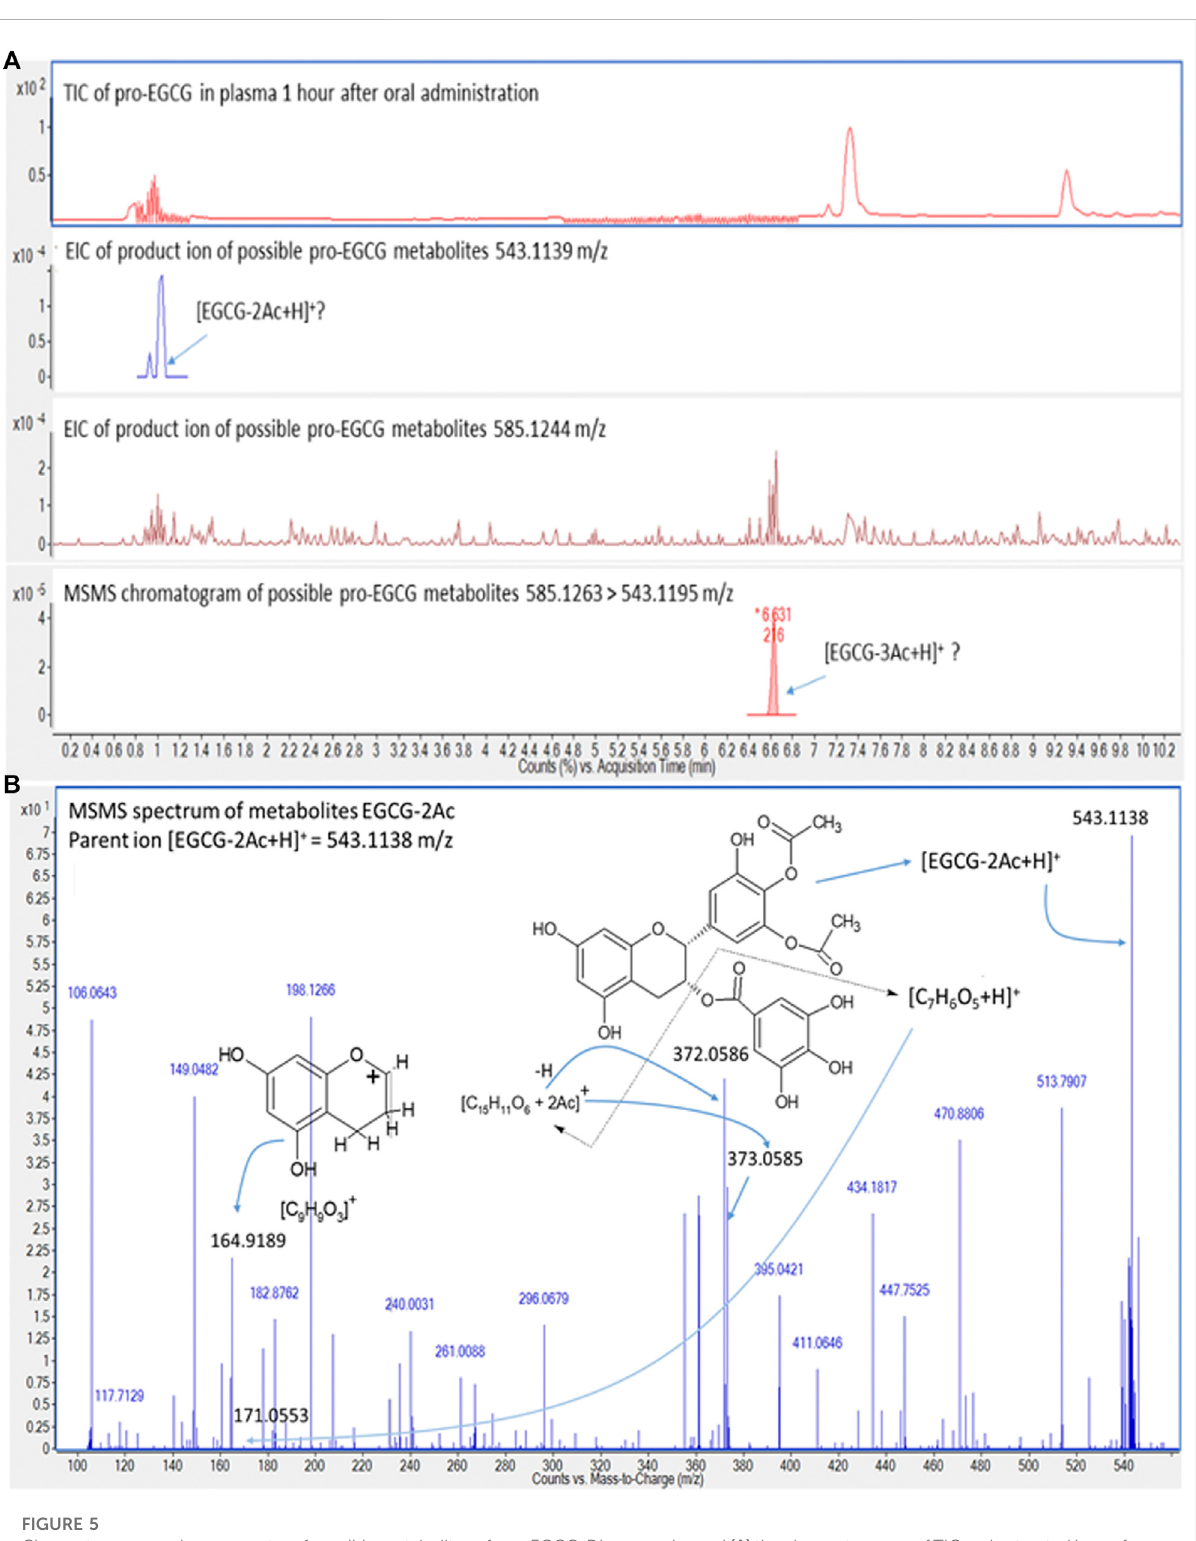
FIGURE 5 Chromatogramsandmassspectraofpossiblemetabolitesofpro-EGCG.Diagramsshowed (A) thechromatogramsofTICandextractedionsof the proposed metabolites, EGCG diacetates [EGCG-2Ac + H]+ (second chromatogram) and EGCG triacetates [EGCG-3Ac + H]+ (third chromatogram) in plasma extract 1 h after oral administration of 50 mg/kg pro-EGCG; (B) the MS/MS spectrum of ion 543.1138 m/z supported the peak could be[EGCG-2Ac+H]+; (C) possible metabolite, EGCG triacetate,was deducedby thefragmentationof [EGCG – 3Ac+H]+, ion mass at 384.2365 m/z, and was further supported by the fourth MS/MS